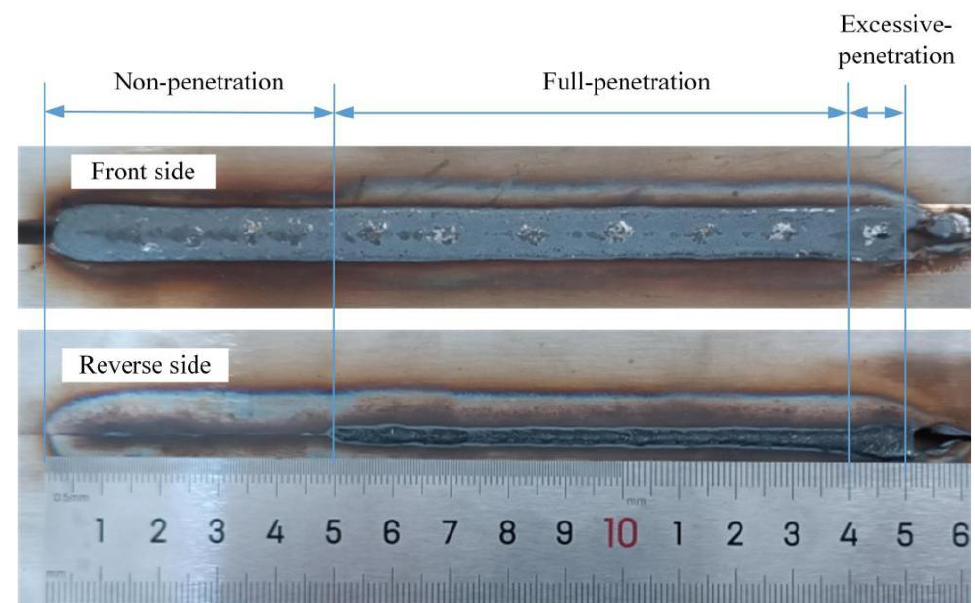
Figure 3. The penetration state of a variable groove